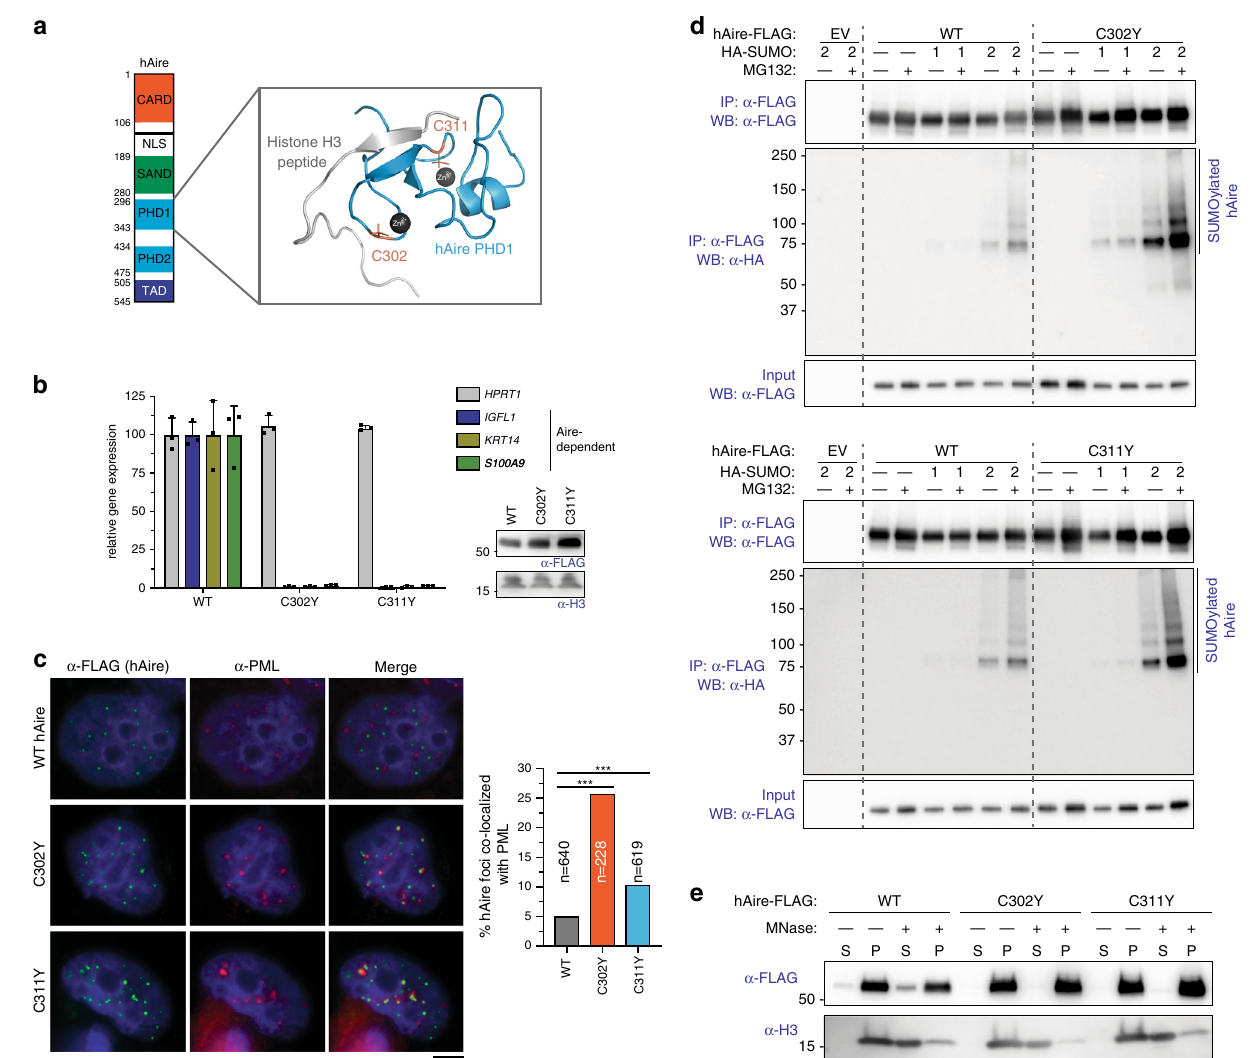
Fig. 6 APS-1 mutations C302Y and C311Y increase PML association. a 3D structure of Aire PHD1 domain bound to histone H3-derived peptide (PDB ID: 2KFT [https://doi.org/10.2210/pdb2KFT/pdb]). C302 and C311, which coordinate Zn 2 + ions, are mutated in APS-1 patients (highlighted in orange). b Transcriptional activity of hAire WT, C302Y and C311Y. Experiments were performed as in Fig. 1g and are presented as mean ± s.d., n = 3. c Representative fl uorescence microscopy images of hAire C302Y and C311Y variants in 4D6 cells. Right, quantitation of Aire foci colocalized with PML bodies. n = number of Aire foci examined per sample. Statistical signi fi cance comparisons were calculated using a two-tailed Student ’ s t -test for two population proportions where each population consists of all individual Aire foci examined. *** p = 2.6e-18 (C302Y) and 0.0004 (C311Y). d SUMOylation analysis of hAire WT, C302Y (top) and C311Y (bottom). Experiments were performed as in Fig. 3c. e Chromatin fractionation analysis of hAire WT, C302Y and C311Y. Experiments were performed as in Fig.